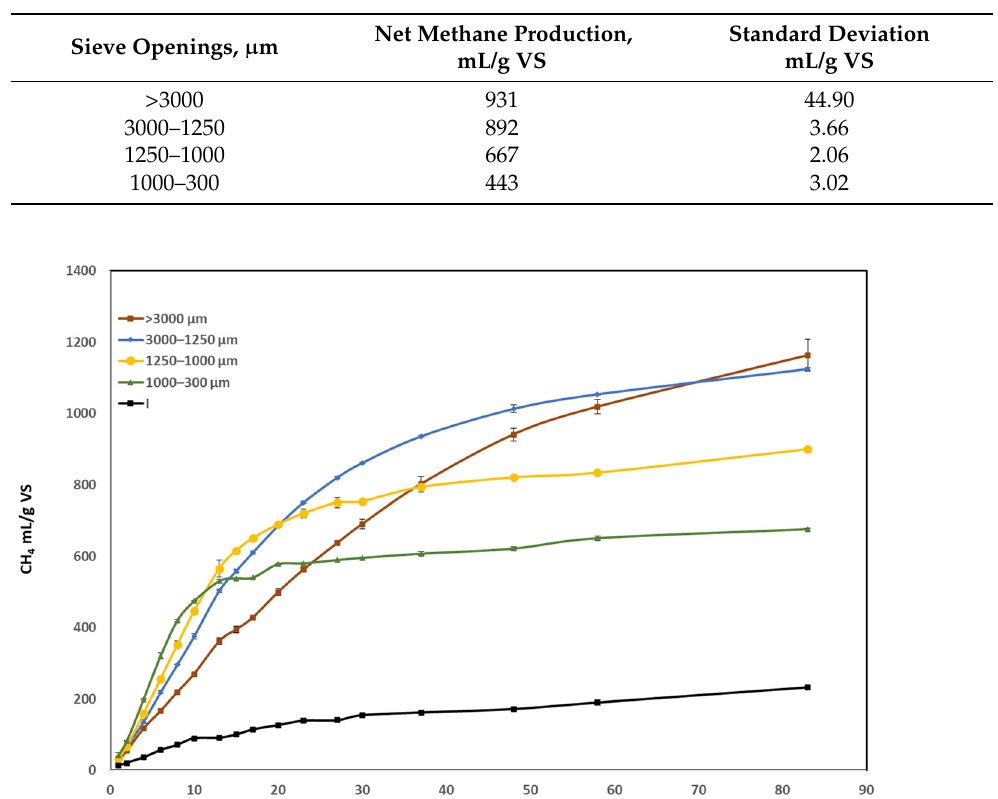
Figure 1. Concentration of total and volatile solids in the samples collected from sieves with various opening sizes. Table 1. Total net methane production for solid samples produced from sieves with openings of different sizes, in mL/g VS.